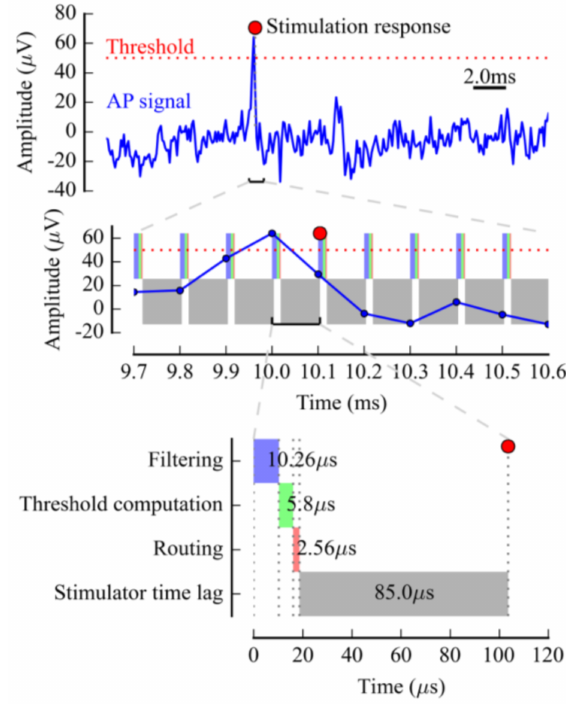
Figure 7. Timing example of a feedback stimulation chain in a neuron culture. Simple spike detection was used with linear filtering, adaptive threshold, and direct routing. The colored time intervals represent the system computation lag. The stimulator time lag, represented in gray, is also taken into account. The time lag shown is that of the MCS STG 4004 Stimulation Generator (STG 4004, MCS, Reutlingen, Germany), which was previously used with the system. The “stimulation response” mark represents the instant at which the electrical stimulus was